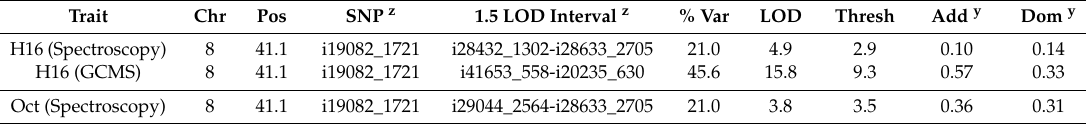
Table 6. Comparison of chromosome (Chr) and position (Pos) in centiMorgans of the most significant single nucleotide polymorphism (SNP), SNPs flanking the 1.5 logarithm of odds (LOD) confidence interval, percent variation (% Var) explained, LOD threshold (Thresh) values from the permutation analysis,